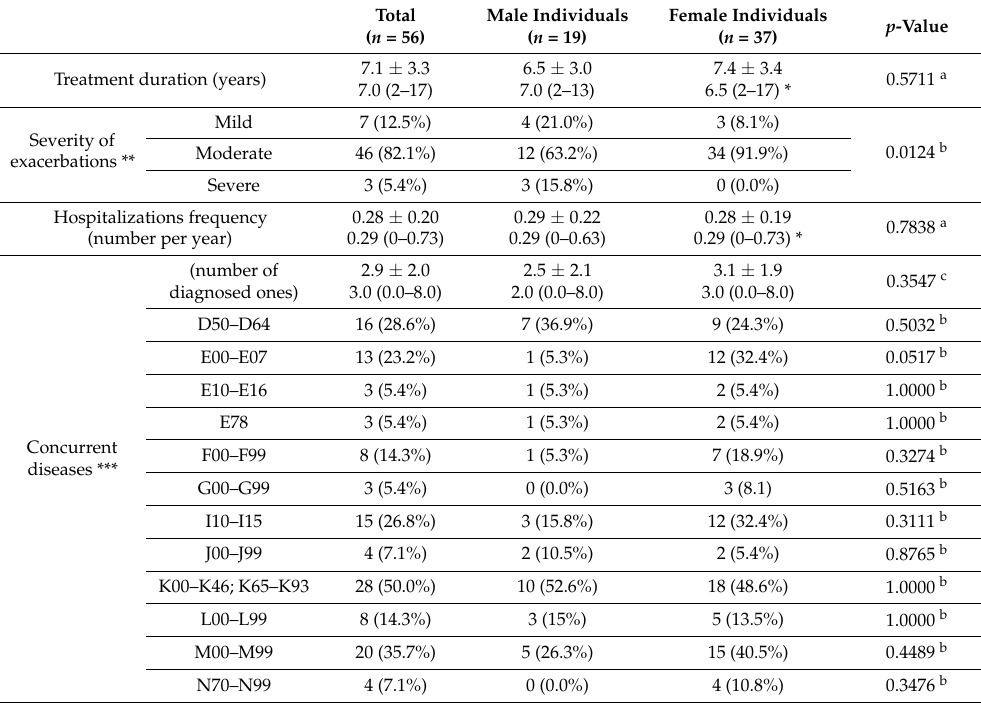
Table 2. The basic characteristics of the disease course for a group of individuals with ulcerative colitis in remission phase recruited for the